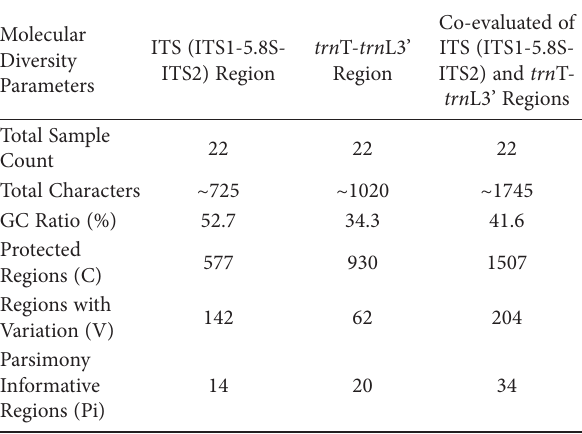
Table 6. PCR amplified region length and summary statistics from the rDNA ITS (ITS1-5.8S-ITS2) and the cpDNA ( trn T -trn L3’) data- set of genus Artemisia .